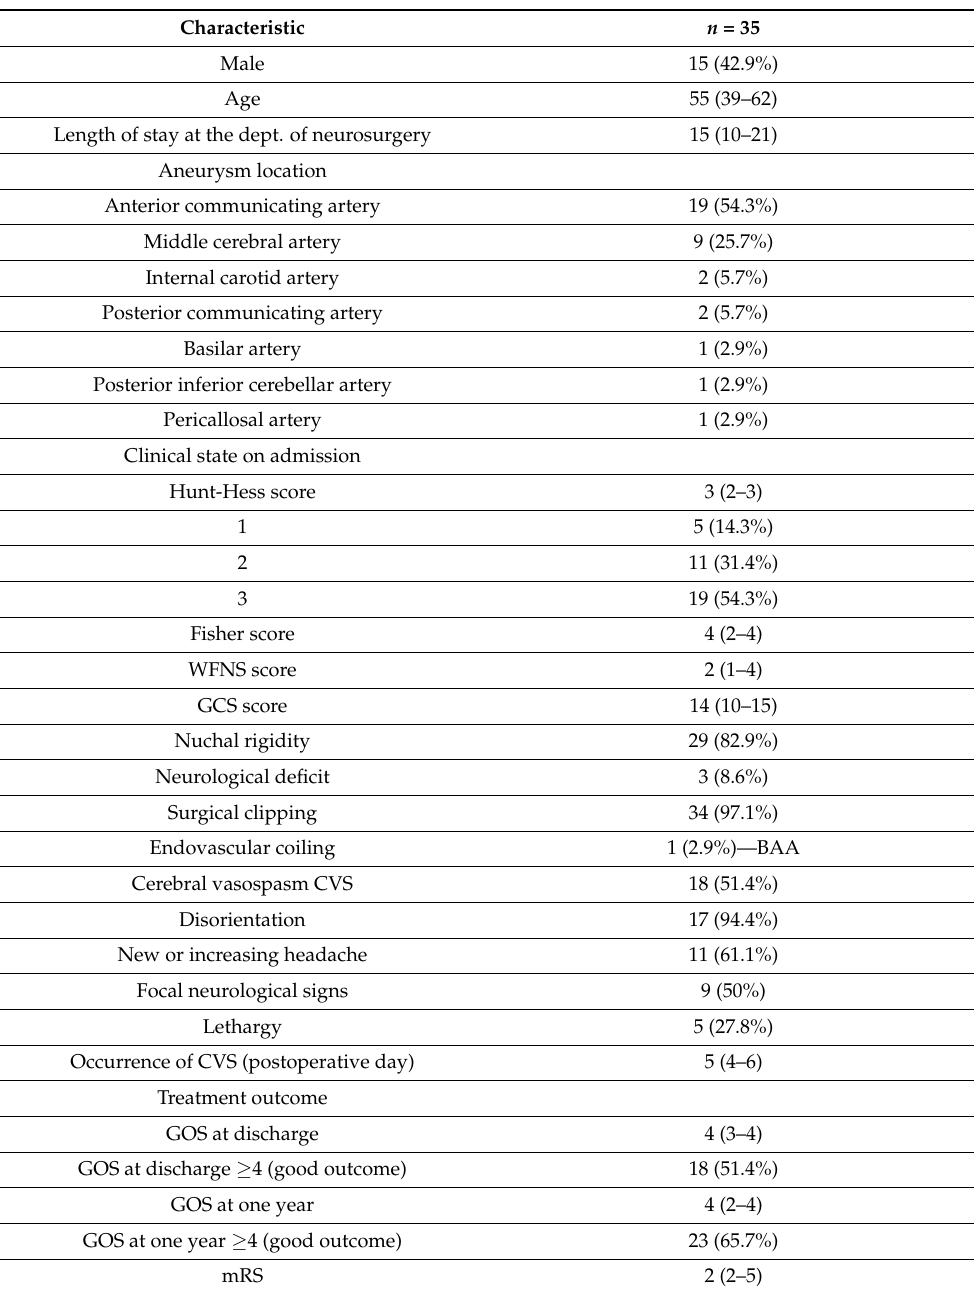
Table 2. Study group